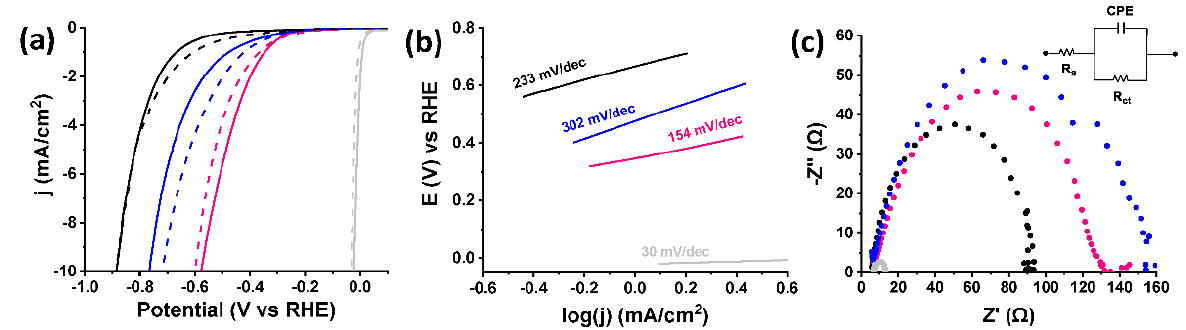
Figure 8. ( a ) LSV polarization curves for HER before (solid lines) and after (dashed lines) 10,000 catalytic cycles, and ( b ) Tafel slope, of exfoliated graphene (black), [Co]-pyr-graphene (pink), [Co]-imi-graphene (blue) and Pt/C (light grey). The LSVs were obtained at 1600 rpm rotation speed and 5 mV/s scan rate in N 2 -saturated aqueous 0.5 M H 2 SO 4 . The current densities are normalized to the geometric electrode area. ( c ) Nyquist plots of [Co]-pyr-graphene (pink), [Co]-imi-graphene (blue), exfoliated graphene (black) and benchmarck HER electrocatalyst Pt/C (light grey). Inset: Equivalent circuit used for fitting the EIS data. Rs refers to the overall series resistance, Rct to the charge transfer resistance and CPE to the constant phase angle element, which represents the double layer capacitance of solid electrode in a realistic situation. The EIS measurements (Nyquist plots) were recorded at the low overpotential (kinetic) region.